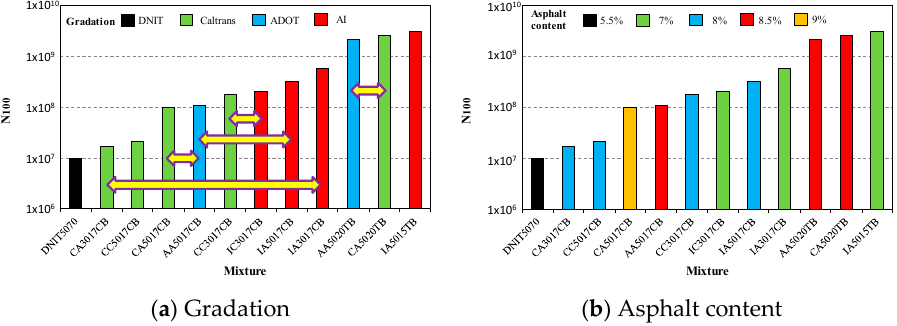
Figure 7. Influence of aggregate gradation ( a ) and asphalt content ( b ) on fatigue resistance. According to Figure 7a, the dense (AI) and gap (Caltrans and ADOT) gradations pre- sented similar fatigue resistances when other parameters were fixed (see CA5017CB vs. AA5017CB; CC3017CB vs. IC3017CB; AA5020TB vs. CA5020TB), but there were also some differences (see CA3017CB vs. IA3017CB; AA5017CB vs. IA5017CB). This means that the